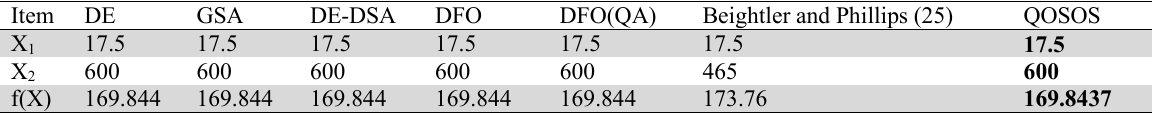
Performance results of DE, GSA, DE-GSA, DFO and QOSOS on Optimal Capacity of the Gas production facilities optimization problem. Boldface represents the best result among the compared